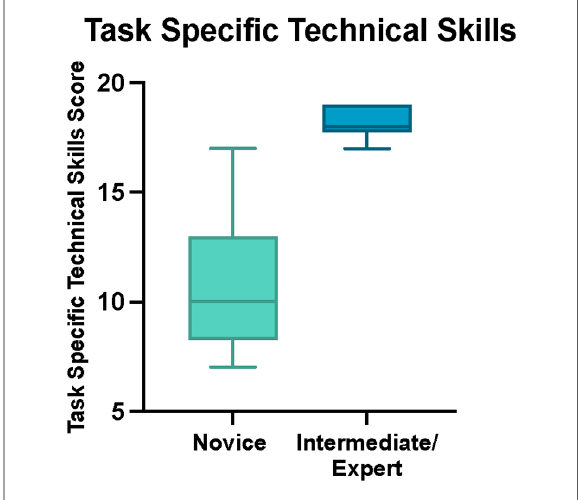
FIGURE 6 Total task speci fi c technical skills score for novice and intermediate and expert participants. The horizontal solid line in the middle of the box is the median value of the scores and the lower and upper boundaries indicate the 25th and 75th percentiles, respectively. The largest and smallest observed values are shown; lines (whiskers) are drawn from the ends of the box to those